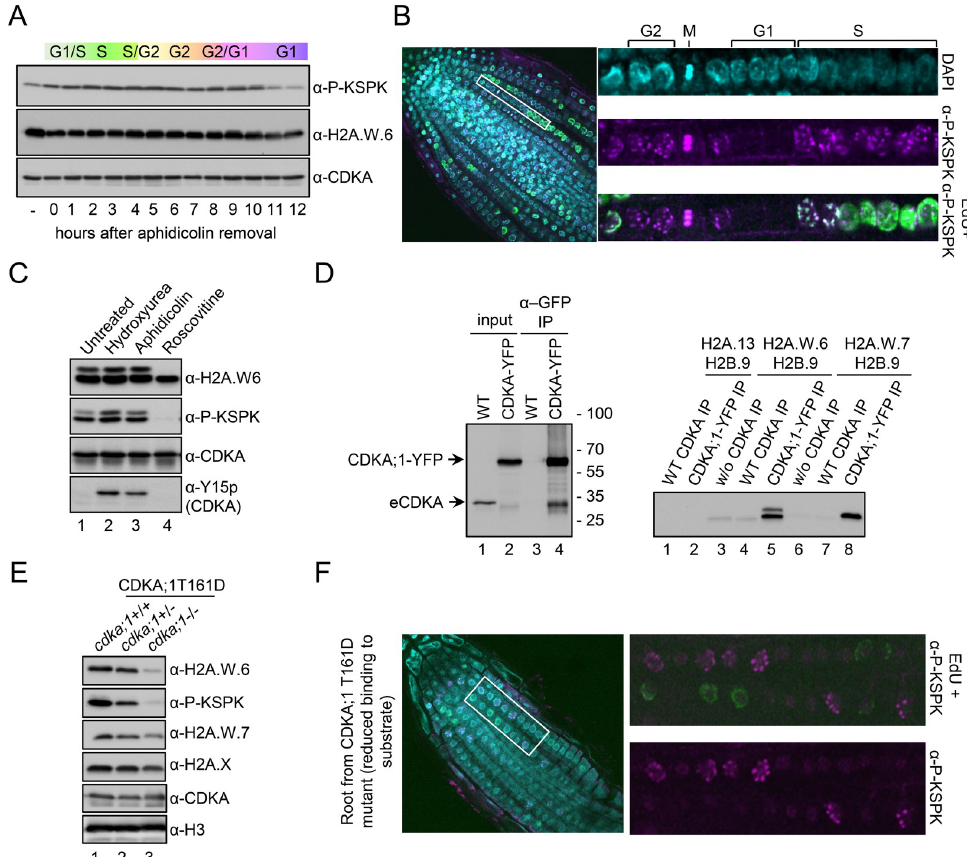
Fig 3. H2A.W.6 is phosphorylated in a cell cycle dependent manner by cyclin dependent protein kinases (CDK). (A) Phosphorylation of the KSPK motif is cell cycle dependent in tobacco BY-2 cell suspension culture. BY-2 cells were synchronized with 20 μ g/ml aphidicolin for 24 hours. Protein extracts from samples taken in one-hour intervals after release of the block were analyzed by western blotting with the indicated antibodies. (B) Confocal images of WT root tips immunostained with H2A.W.6p antibody (magenta) after EdU (green) incorporation. Enlarged images of a row of cells in different cell cycle stages (indicated on the top) are shown on the right. (C) Protein extracts from Arabidopsis cell suspension treated with cell cycle inhibitors were analyzed by western blotting with the indicated antibodies. Inhibitory phosphorylation of CDK at tyrosine 15 (Y15) upon hydroxyurea and aphidicolin treatment (bottom panel, lanes 2 and 3) demonstrate the specificity and robustness of the assay. By contrast, roscovitine that inhibits the CDK activity directly by binding to the ATP binding pocket does not induce Y15 phosphorylation. (D) Arabidopsis CDKA;1-YFP was immunoprecipitated from whole cell extracts and detected with an anti-CDK antibody (left panel, lanes 2 and 4) and used in an in vitro kinase assay (right panel) with recombinant histone H2A-H2B dimers as indicated. Phosphorylation of the KSPK motif was detected by western blotting with P-KSPK antibody. Note that GFP beads do not precipitate wild-type CDKA;1 (left panel, lane 3) and consequently P-KSPK was not detected in kinase assays from these IPs (right panel, lanes 4 and 7). (E) Transgenic plants expressing weak hypomorphic mutant of CDKA;1, named D, in the cdka;1 mutant background, were genotyped to identify heterozygous and homozygous plants ( cdka;1 +/- and cdka;1 -/-). Nuclear protein extracts from 2-weeks old seedlings were analyzed by western blotting with the indicated antibodies. (F) CDKB;1, which is active at the G2/M transition, also phosphorylates the KSPK motif of H2A.W.6. Root tips of plants expressing the CDKA;1 T161D hypomorphic mutant that results in reduced substrate binding were immunostained with the P-KSPK antibody (magenta) after EdU incorporation (green). Enlarged images on the right demonstrate the presence of P-KSPK in G2 nuclei but not in S phase nuclei labeled with EdU. A single confocal section is